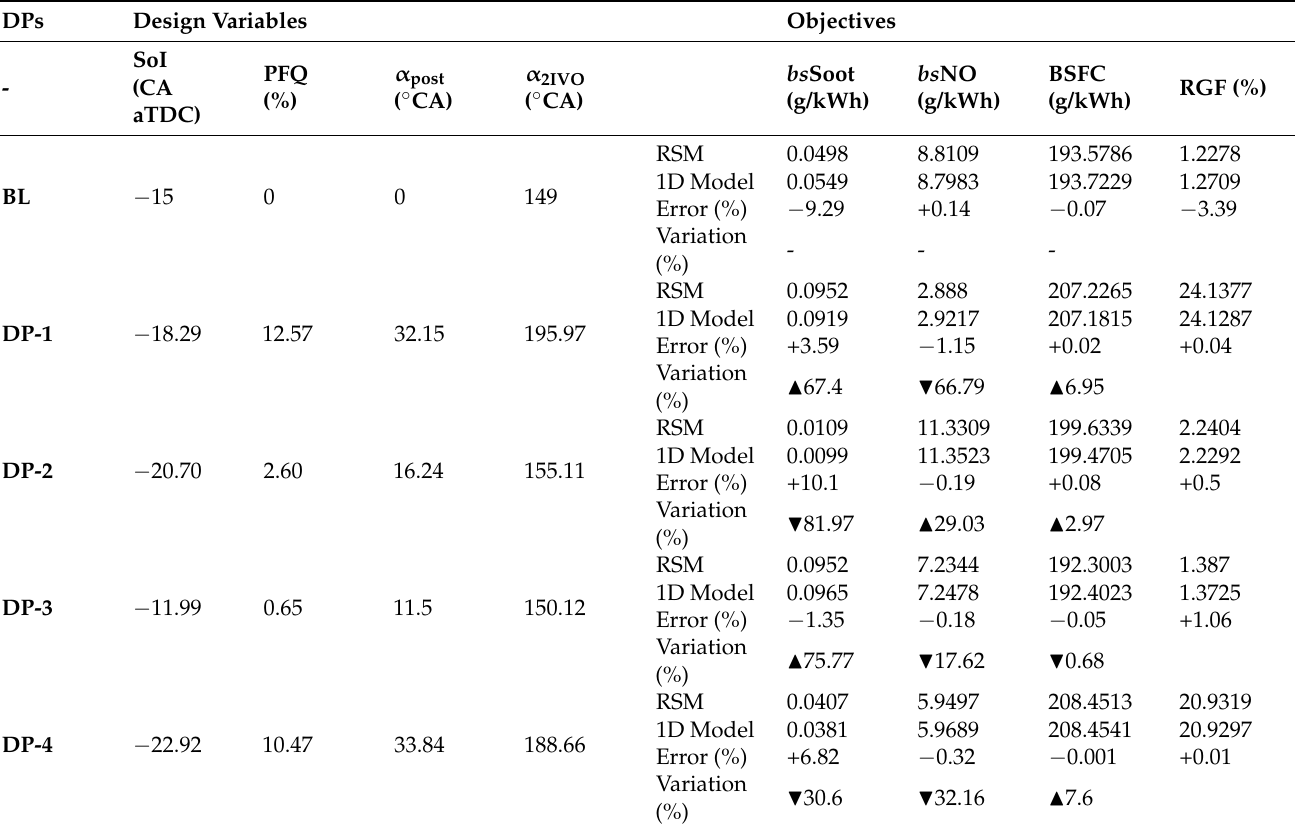
Table 4. Design variables and objective values corresponding to selected four optimal design points. DPs Design